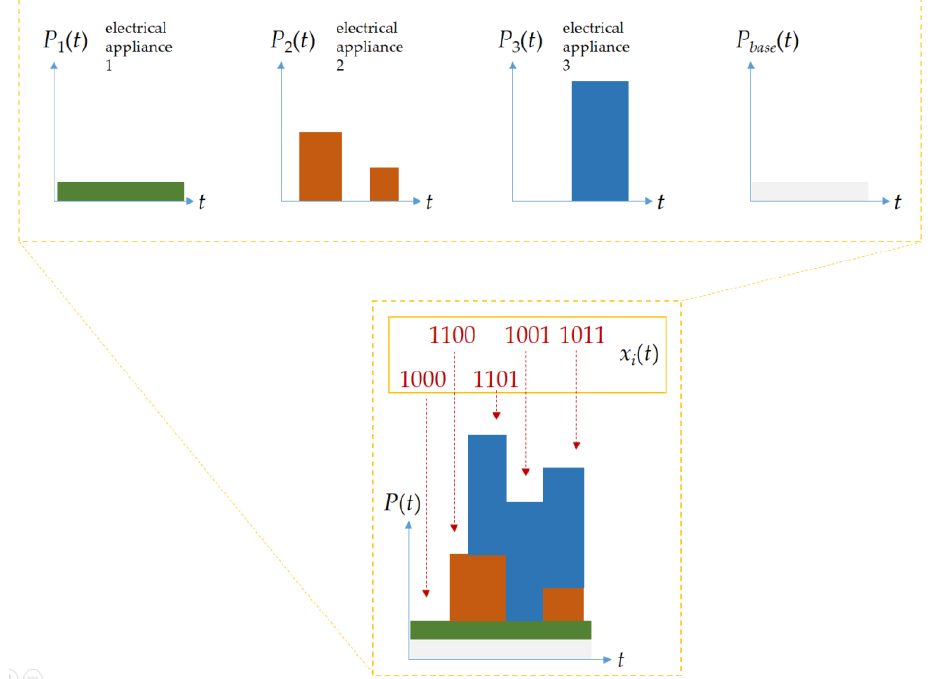
Figure 2. An illustration of the principle of combinatorial search for load combinations to x i ( t ) for load disaggregation in this paper, whereby load combinations by x i ( t ) are optimized. x i ( t ) is represented as a binary vector, evolved through metaheuristics, and used to minimize Equation (2) between the summation of superimposed absorptions Σ x i ( t ) P i ( t ) with an unmonitored base load P base ( t ) and the total load P ( t ).